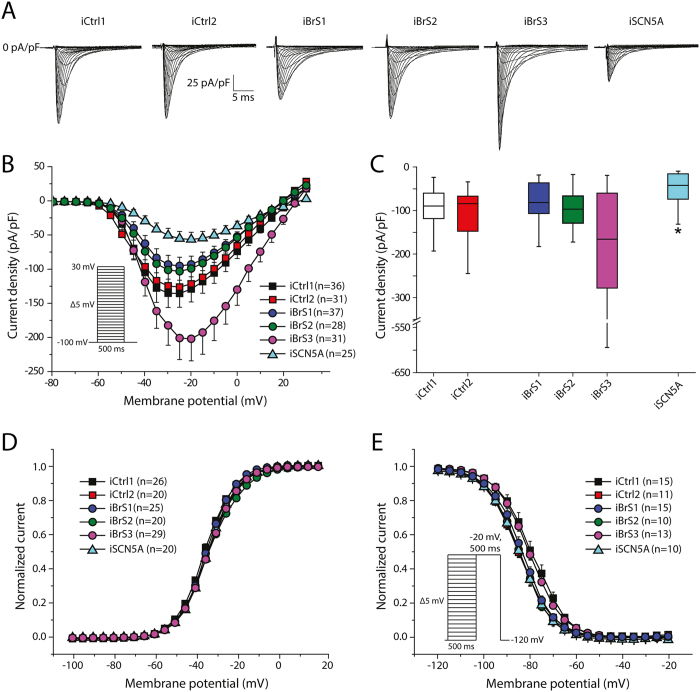
Sodium current (INa) characterization in hiPSC-CMs from iCtrl1, iCtrl2, the three BrS patients iBrS1 to iBrS3 and iSCN5A.(A) Representative traces of INa as determined by the voltage clamp protocol shown in the inset of (B). (B) Current-voltage (I-V) relationships of peak INa (mean ± SEM). (C) Boxplots depicting INa densities (median, boxes represent interquartile range, whiskers 95% interval), determined at −20 mV. *indicates significance compared to iCtrl1 and iCtrl2 (p < 0.05; Kruskal-Wallis test, followed by pairwise comparisons). (D) Voltage dependence of activation. (E) Voltage dependence of inactivation. The inset represents the voltage clamp protocol that was applied.